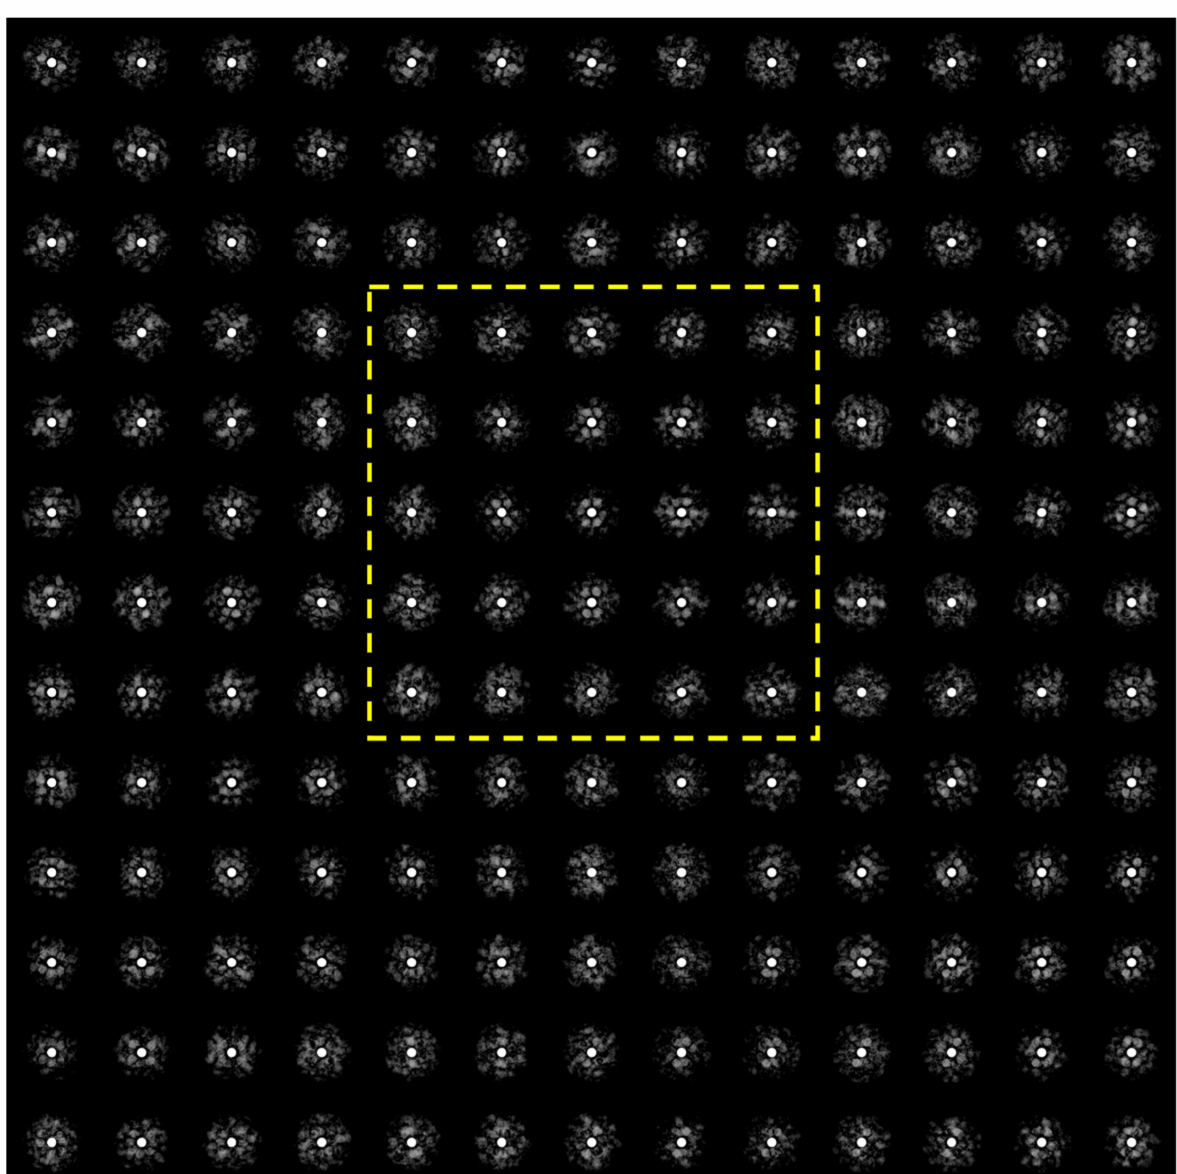
Figure 2. Calculated electron diffraction patterns from the positions shown in Figure 1b. The 25 electron diffraction patterns surrounded by the dotted lines in Figure 2 are shown in Figure 3a. Focusing on the diffraction pattern, we can see that two pairs of diffraction spots are clearly visible and that similar patterns are seen around pattern 13. Note that similar electron diffraction patterns have been observed experimentally [16].